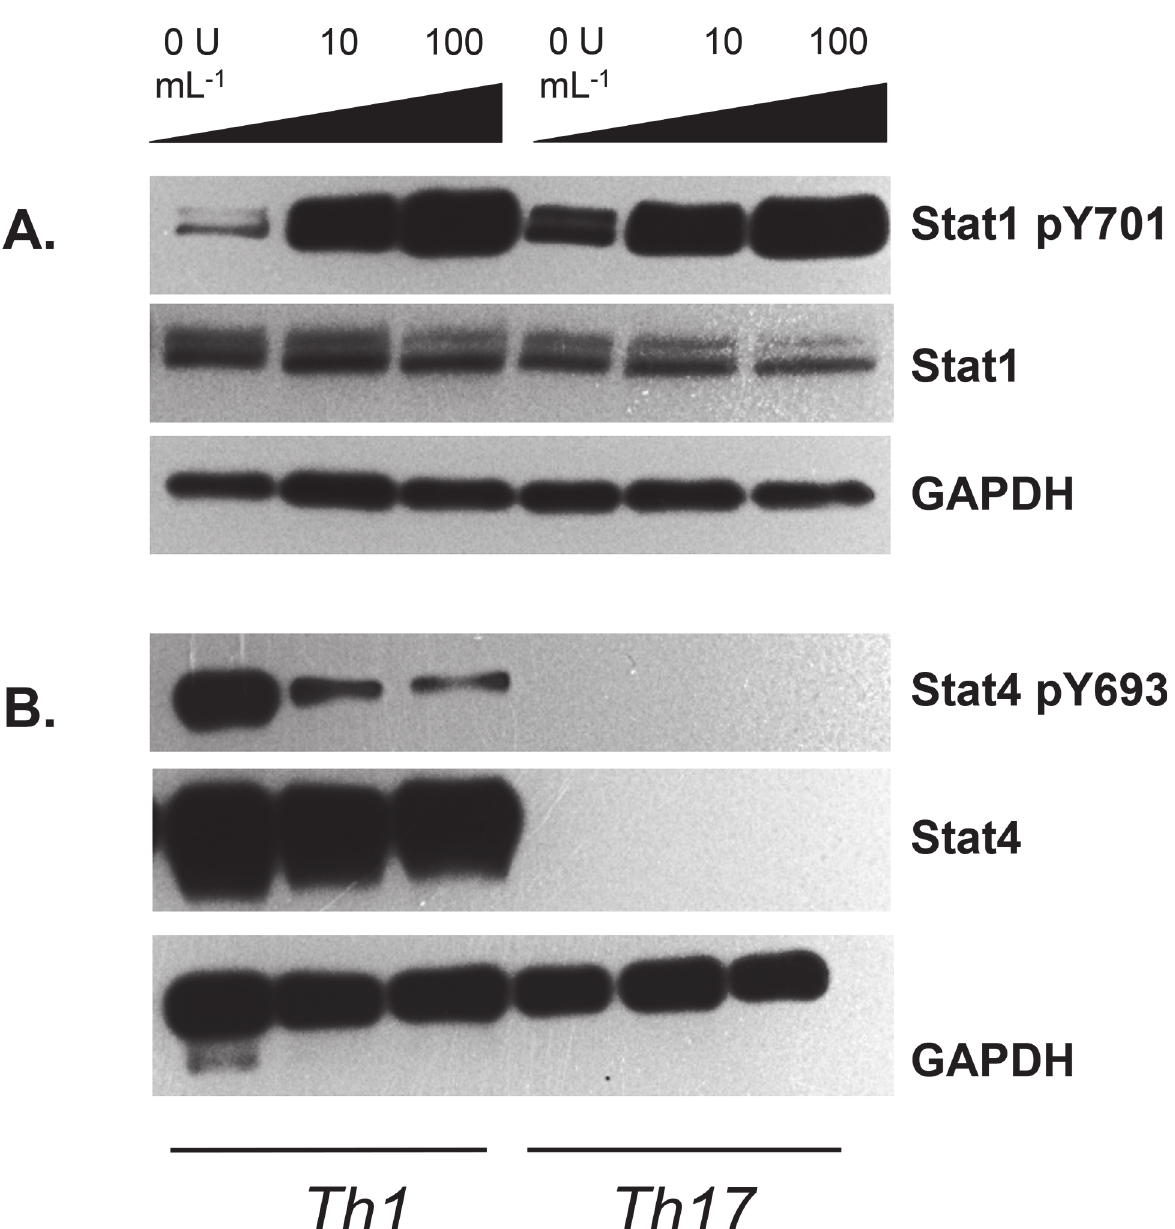
Fig 5. IFN- β regulates Stat1 and Stat4 expression on Th cells in the absence of APCs. CD4 + CD62L hi CD25 - T cells were sorted from the spleens and lymph nodes of C57BL6/J mice. They were stimulated with plate-bound anti-CD3+anti-CD28 under Th1 or Th17 conditions, with the indicated concentrations of IFN- β , for 48 hours, and cell lysates were generated. A. Expression of Stat1 and pStat1(Y701) were assessed by Western blot. Representative of two experiments. B. Expression of Stat4 and pStat4(Y693) were assessed by Western blot. Representative of three experiments. GAPDH, loading